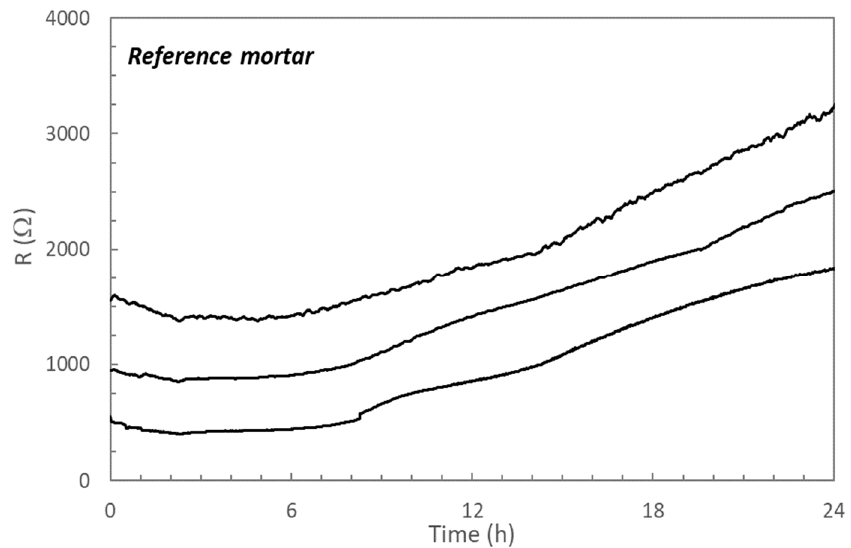
Figure 2. Evolution of the electrical resistance during the first curing day of the reference mortar for the three different sensors embedded in the specimen. the three different sensors embedded in the